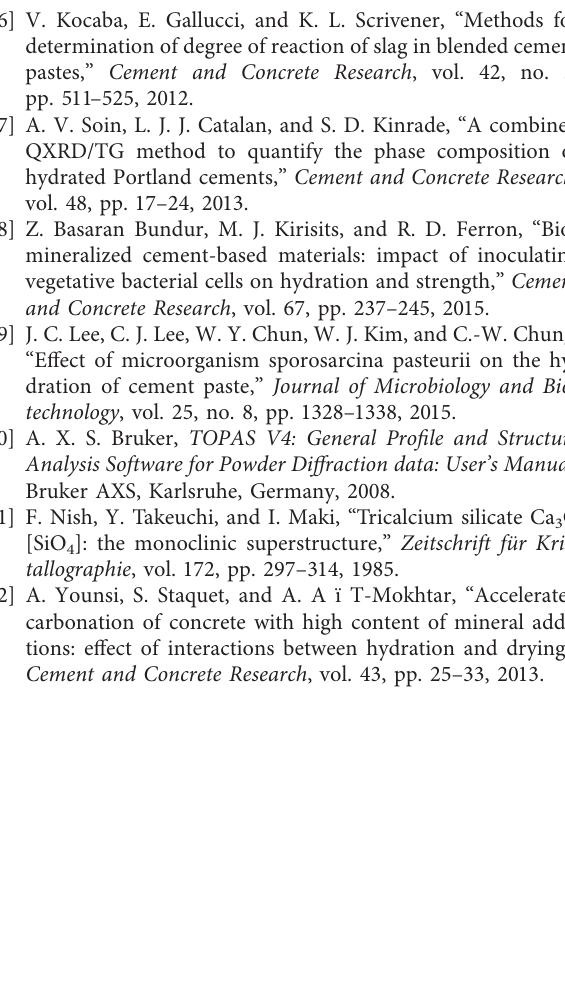
3 S content between EBSD and